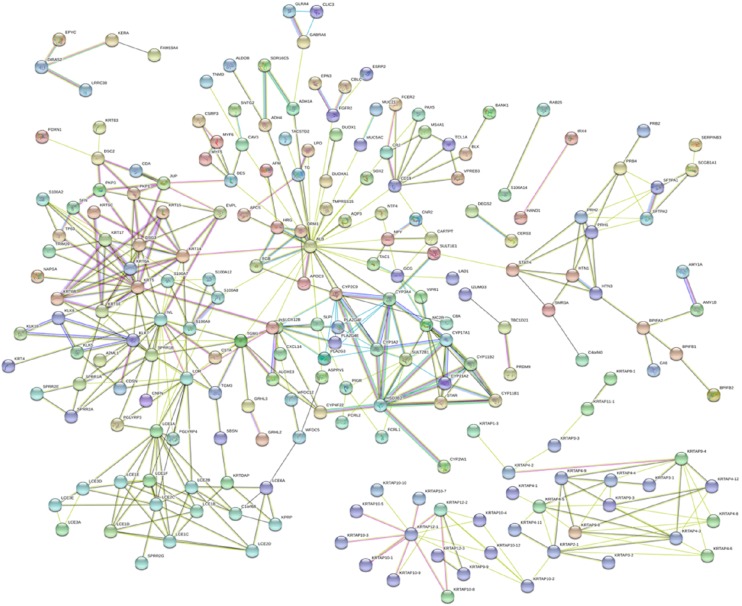
The PPI network constructed by the website STRING (https://string-db.org/). A total of 322 proteins are presented with color nodes; interactions are represented with edges. Only edges with weight (w) above a threshold of 0.4 are displayed.